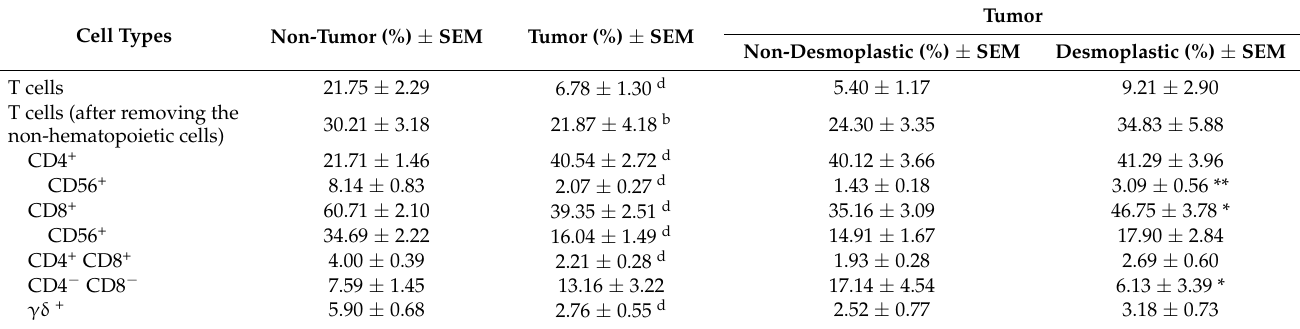
Table 3. Percentage of T cells in non-tumor and tumor samples of liver metastasis of CRC with non-desmoplastic and desmoplastic growth